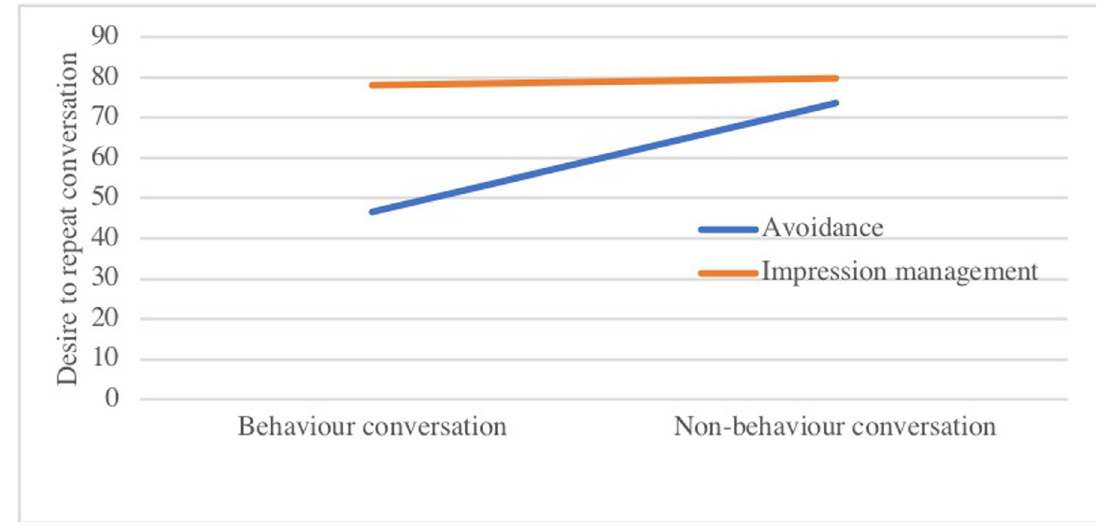
Fig 5. Interaction effect of safety behaviour type and conversation type on desire to repeat conversation.